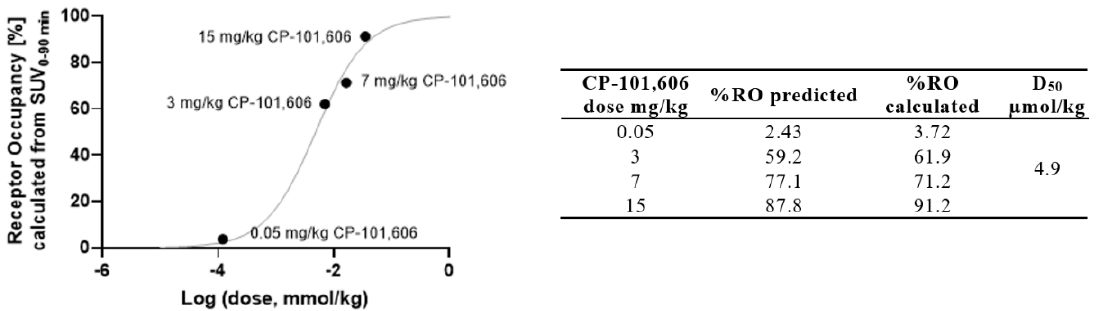
Figure 4. In vivo receptor occupancy (RO) of GluN1/2B antagonist CP-101,606 in Wistar rats in the presence of the σ1R tracer [ 18 F]fluspidine. Plotting the calculated receptor occupancy against the different dose regimes allowed the calculation of D 50 which is the administered dose of CP-101,606 that occupies 50% of the σ1Rs. [23] .